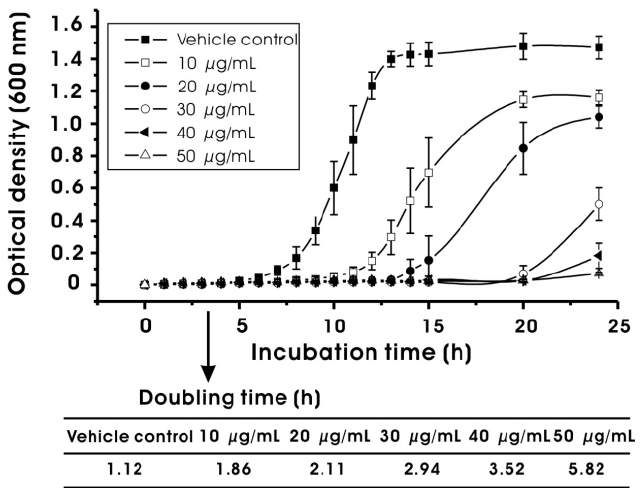
Figure 3. Effect of methanol extract of Dryopteris crassirhizoma root (MED) on the growth rate of Streptococcus mutans . Growth rate was expressed by measuring doubling time (min) in the presence or absence of MED at sub-MIC levels. The vehicle control was 1% DMSO (v/v, final concentration). Data represent mean ± standard